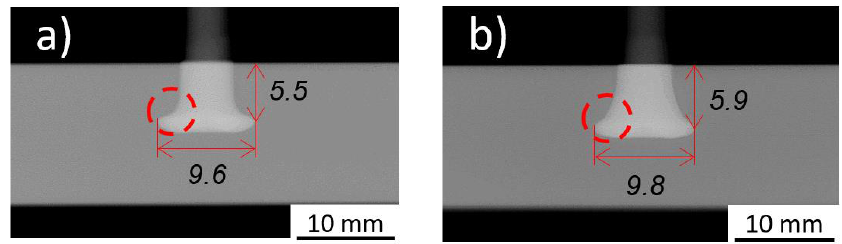
Figure 7. X-ray tomography of: ( a ), Condition 14 (RS = 20,000 rpm; FT = 1.6 s; FoT = 2 s; FF = 3000 N; FoF = 3900 N); and ( b ), Condition 36 (RS = 19,000 rpm; FT = 1.8 s; FoT = 1.5 s; FF = 2500 N; FoF = 5700 N).